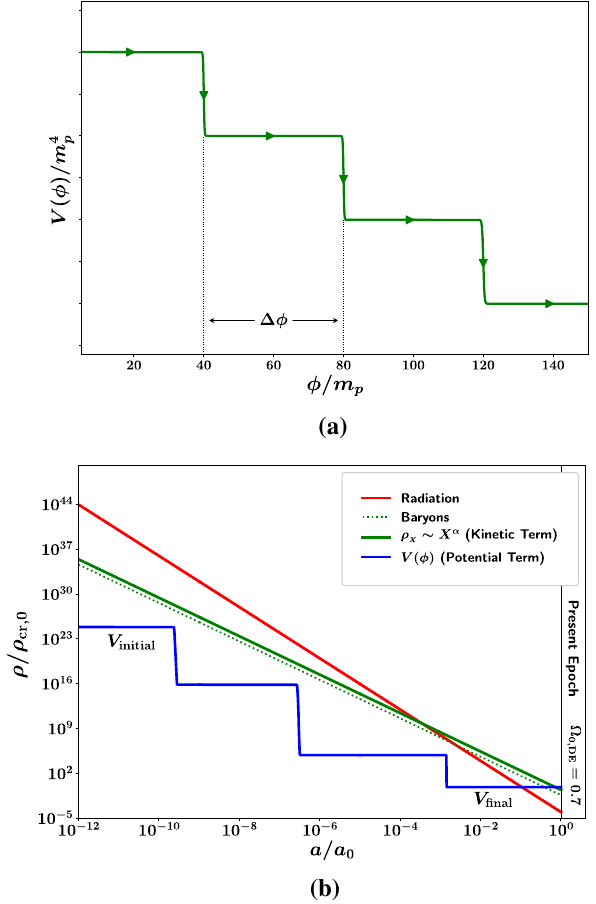
Fig. 9 A schematic view of the cascading potential is shown in (a) , while b shows the evolution in the density of the kinetic term ρ (solid green line) and the cascading potential V (φ) (blue). Also shown are the densities in radiation (red) and baryons (dotted green). (Note that V initial = 10 25 × V final